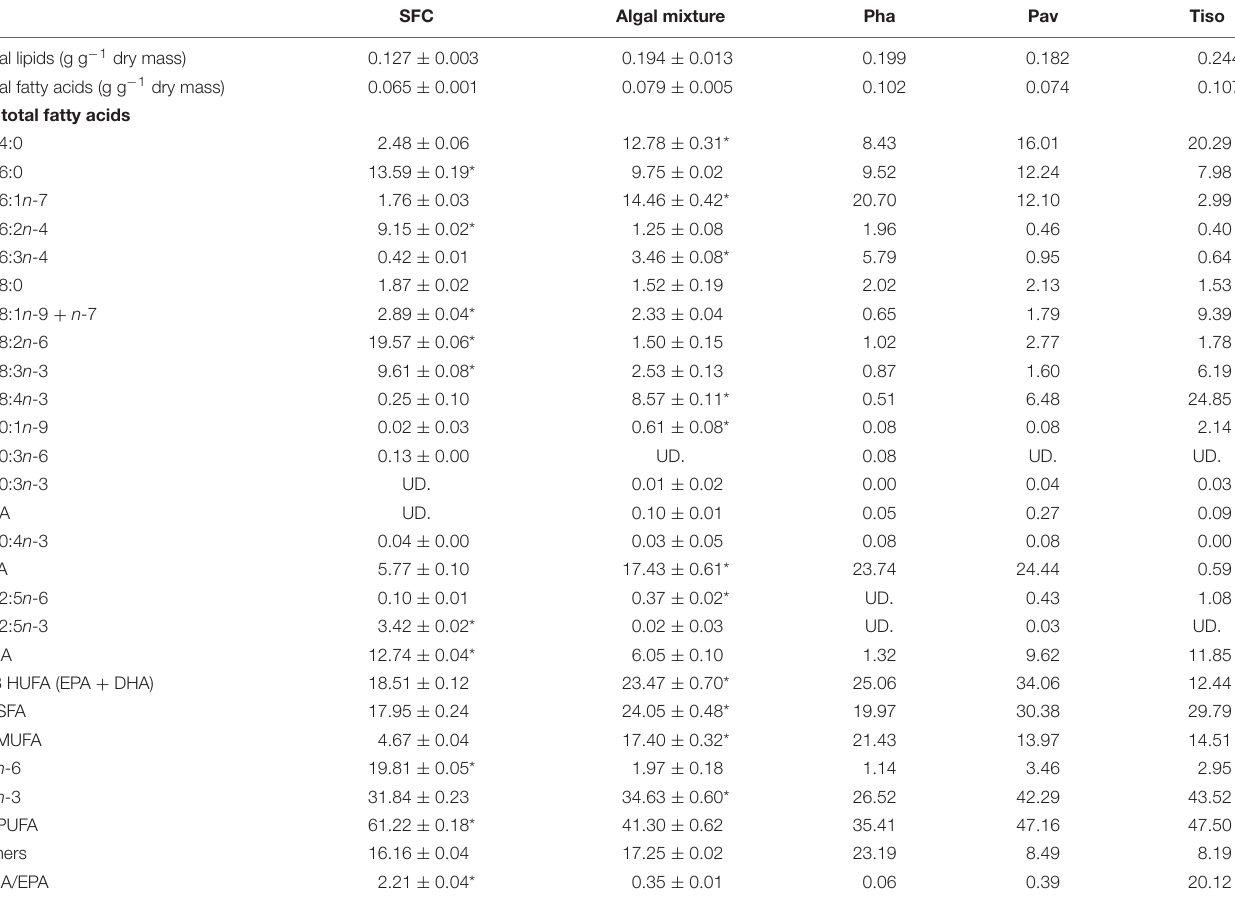
TABLE 1 | Total lipids and their fatty acid proportions in docosahexaenoic acid-supplemented Super Fresh Chlorella (SFC), algae Phaeodactylum (Pha), Pavlova (Pav), and Tisochrysis (Tiso), and their mixture (Algal mixture). SFC Algal mixture Pha Pav Tiso Total lipids (g g − 1 dry mass) 0 . 127 ± 0 .